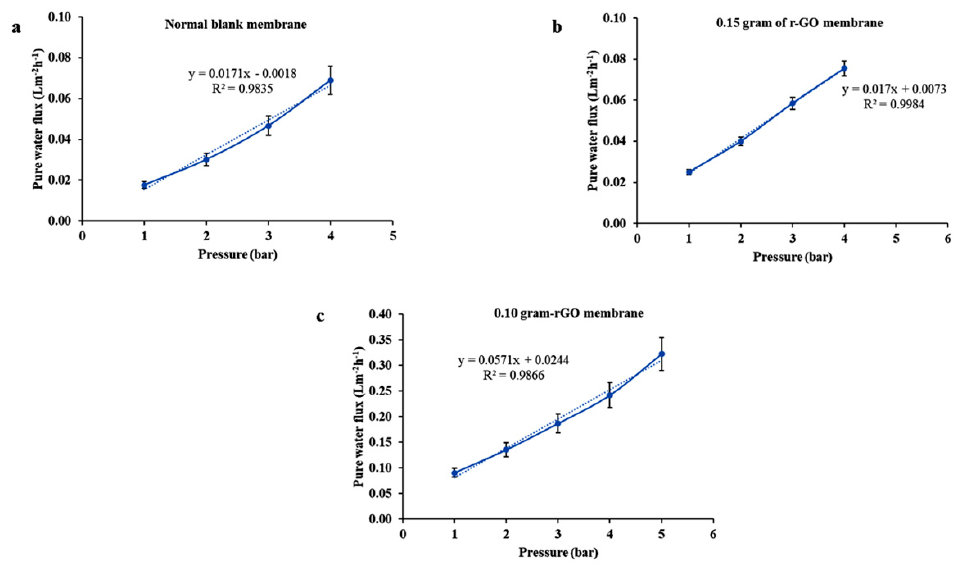
Figure 12. Normal deionized water permeability ( a ) Sample A ( b ) Sample B ( c ) Sample C. Table 2. Normal deionized water permeability.